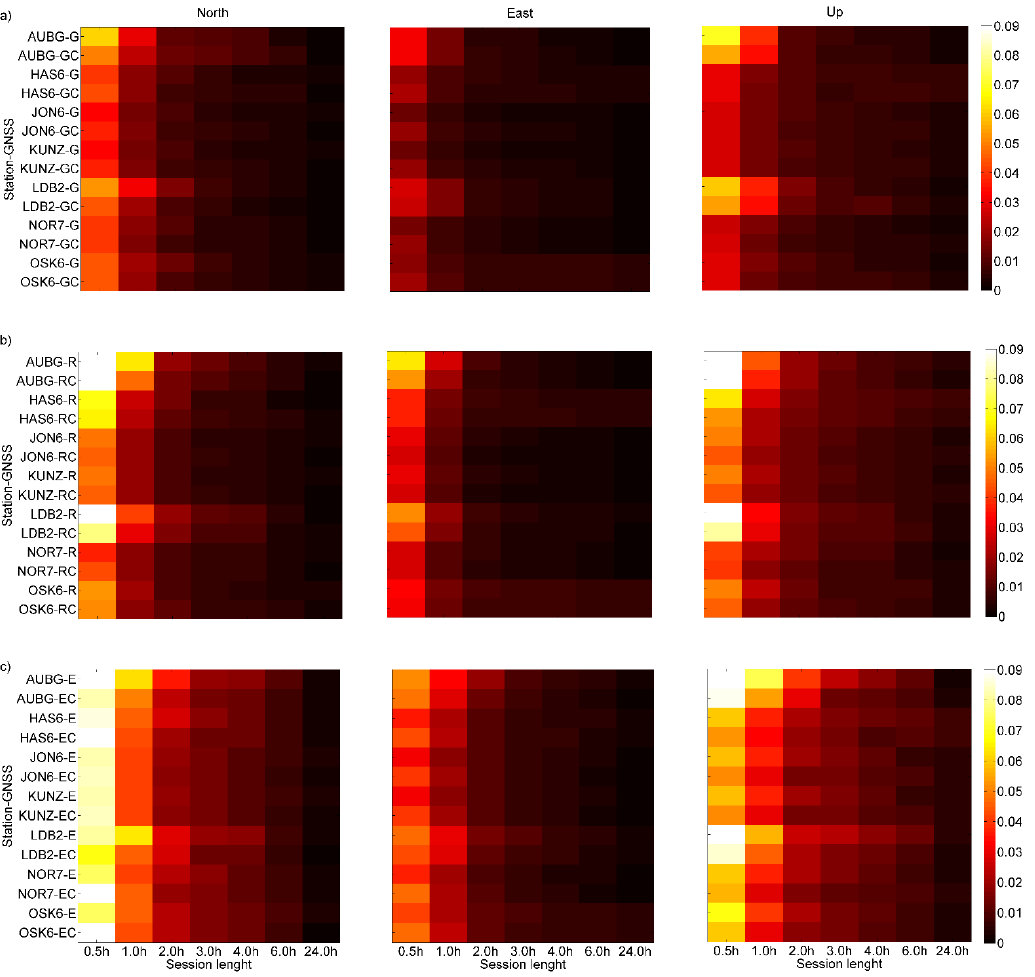
Figure 3. SD for NEU components differences (in meters) for scenarios: a ) I, b ) II, c ) III.